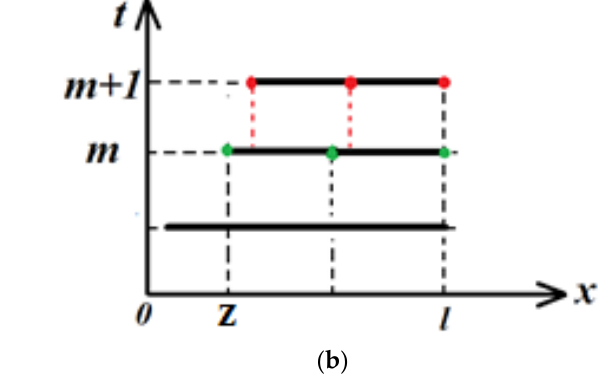
Table 1. Parameters used for calculation. Component 1